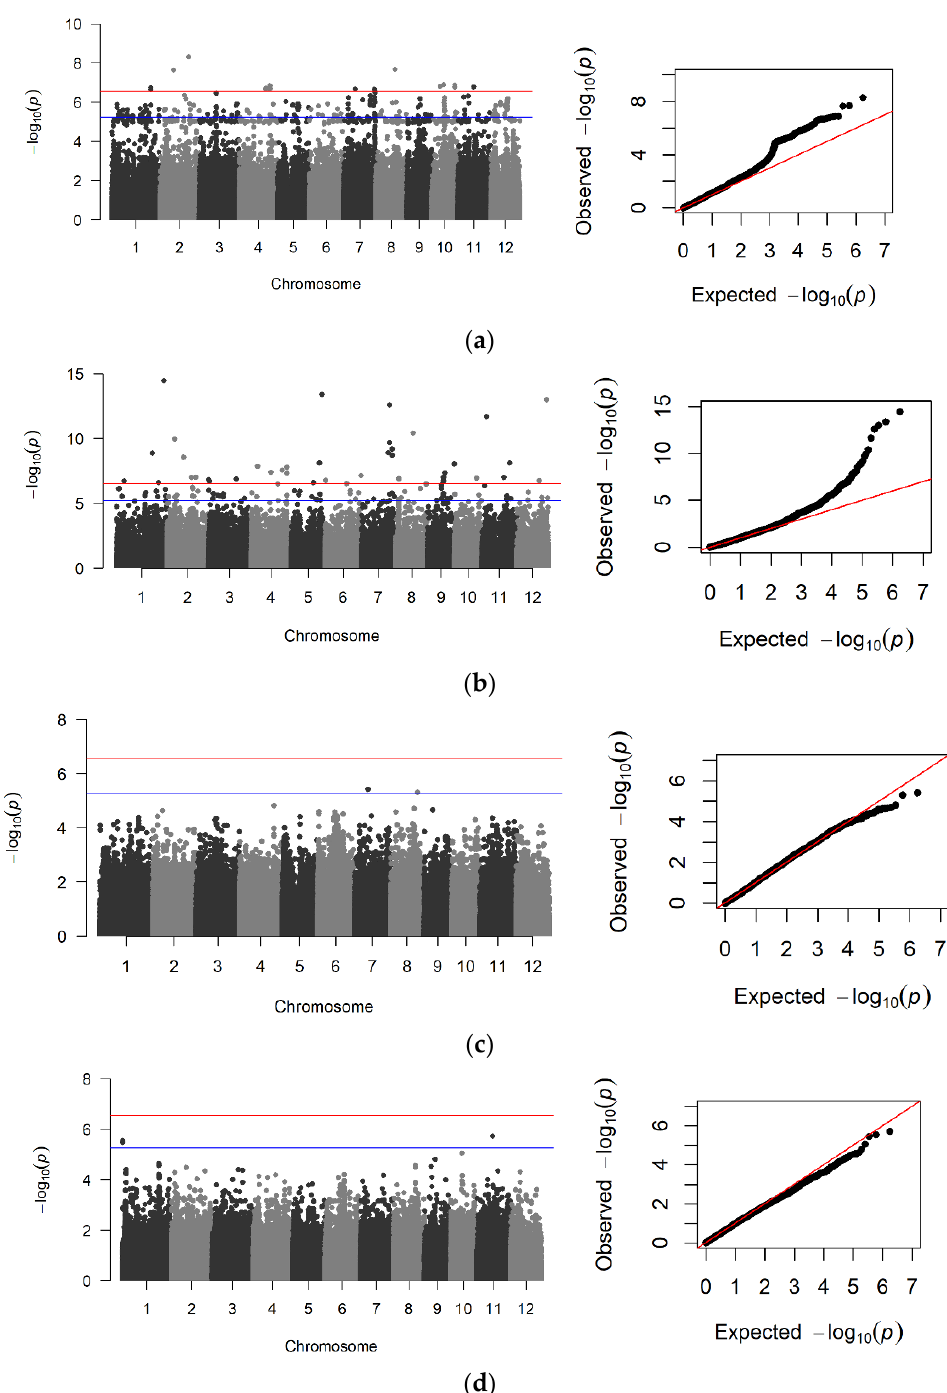
Figure 3. Manhattan and quantile–quantile (Q-Q) plots of GWAS for protein concentration (PC) evaluated in 2018 ( a ) and 2019 ( b ) and apparent amylose concentration (AAC) evaluated in 2018 ( c ) and 2019 ( d ). The red line in Manhattan plots represents the genome-wide significance threshold line ( p < 2.83 × 10 − 7 ), while the blue line in Manhattan plots represents the suggestive significant threshold line (2.83 × 10 − 7 < p < 5.65 × 10 − 6 ) based on the number of independent tests used in the study. Table 2. Significant SNPs detected by GWAS using TASSEL Mixed Linear Model (MLM) associated with milled grain protein and apparent amylose concentrations from the 2018 and 2019 seasons.